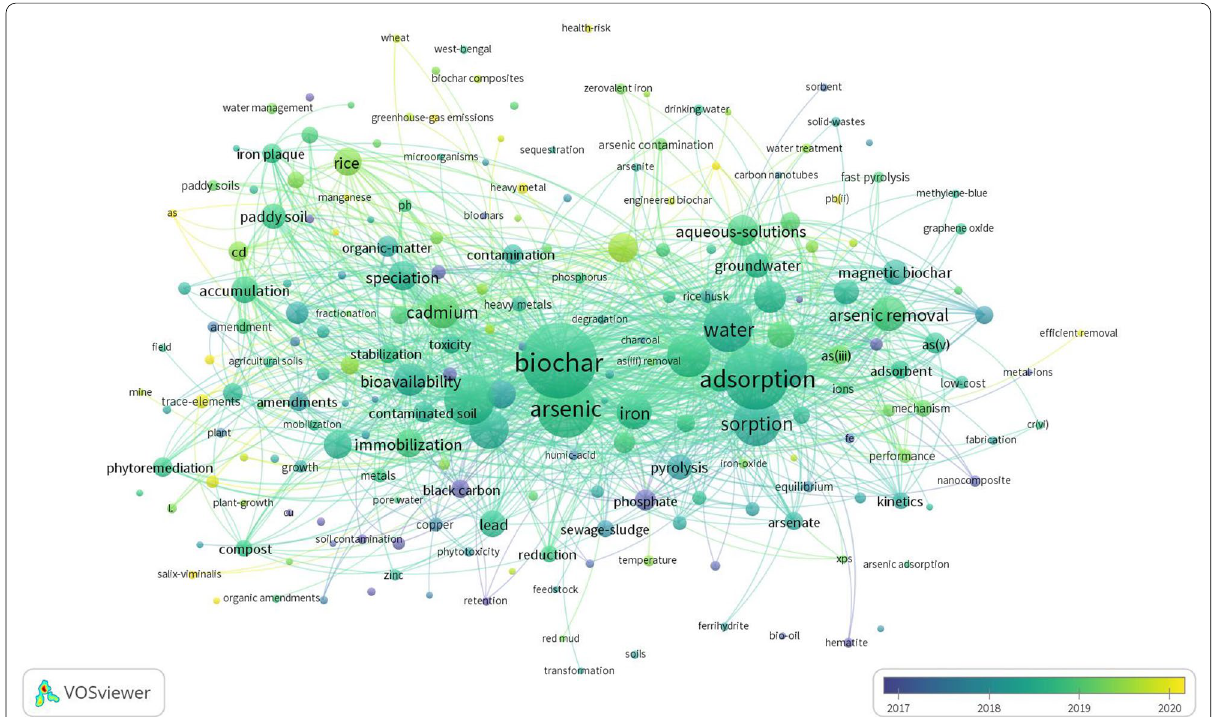
Fig. 1 Scientometrics visualizes the top 50 keywords for all peer‑reviewed publications since 2009. The selected database was the Web of Science Core Collection with 538 papers retrieved based on the keywords (topics) “arsenic” and “biochar”. The data were analyzed using the keyword co‑emergence feature built into VOSviewer, plotted in “Network Visualization,” “Overlay Visualization (year),” and “Density Visualization.” Each circle represents a keyword, and the size of the circle represents the number of times a pair of keywords appears together in a publication. The color‑coded legend shows the average year each keyword